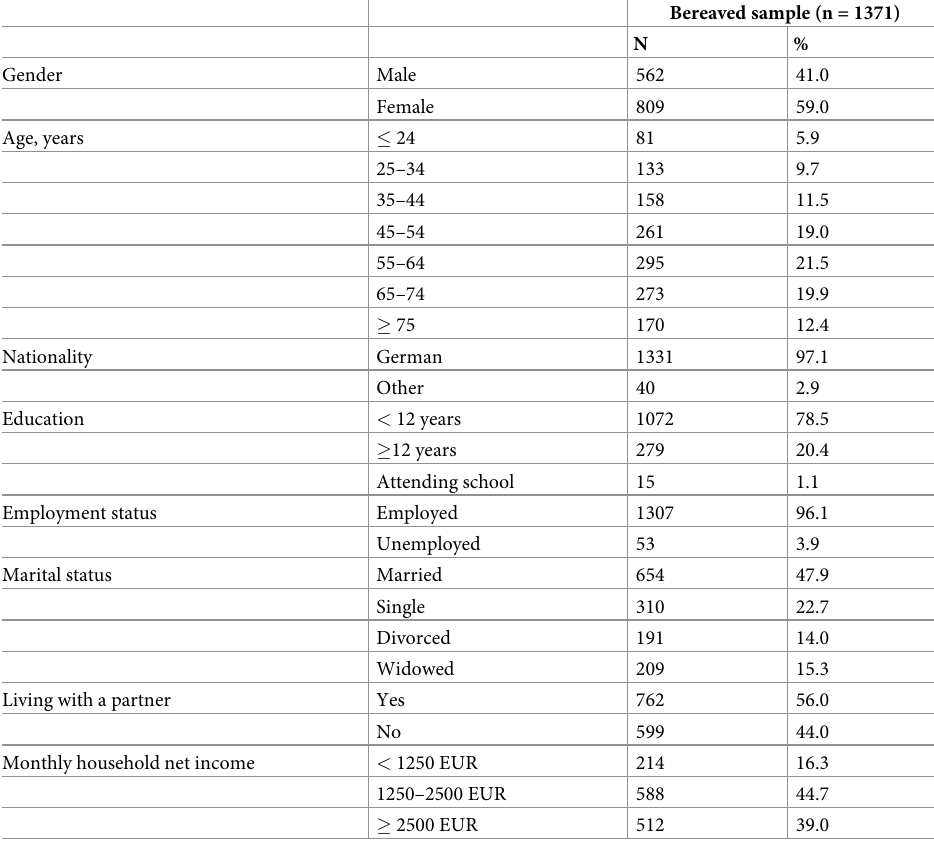
Table 1. Demographic characteristics of the bereaved